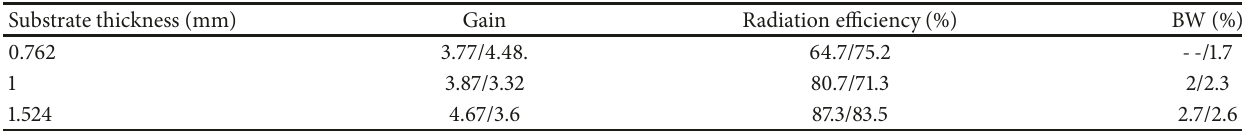
Table 1: The effect of the substrate thickness on the antenna performance.